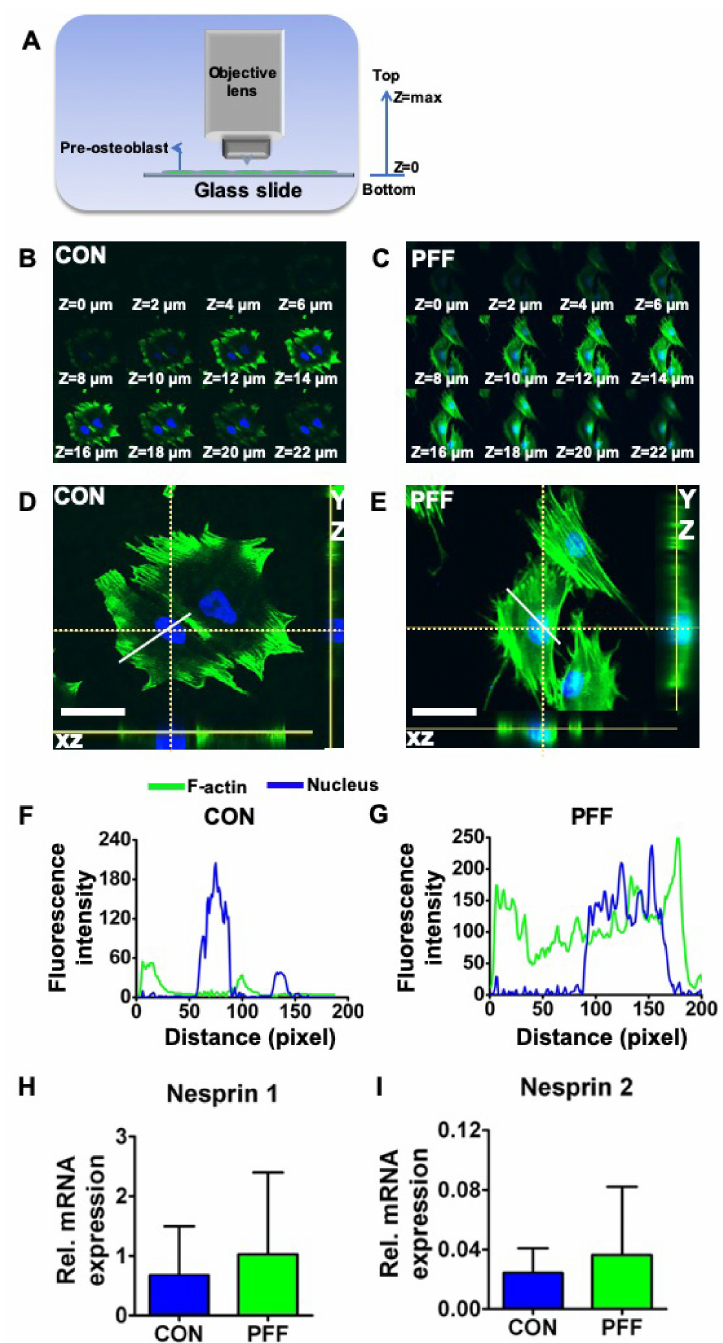
Figure 3. E ff ect of 1 h PFF on 3D F-actin distribution and nucleus position based on morphology and Z-stack analysis by laser scanning confocal microscopy (LSCM), as well as nesprin 1 and 2 gene expression in MC3T3-E1 osteoblasts. ( A ) Illustration of confocal Z-stack scanning direction. ( B ) Z-stack scanning of a typical representative static control cell stained for F-actin and analyzed in the Z-direction at 2 µ m intervals. ( C ) Z-stack scanning of a typical representative 1 h PFF-treated cell. ( D ) Top, XZ, and YZ view of a static control cell. The position of the XZ and XY view are along the dotted white lines. ( E ) Top, XZ, and YZ view of a representative cell, subjected for 1h with PFF. XZ and XY views are along the dotted white lines. ( F ) Fluorescence intensity profiles were analyzed over the solid white line drawn in Figure 3D. ( G ) Fluorescence intensity profiles over representative PFF-treated cells, detected along the solid white line visible in Figure 3E. Bar = 50 µ m. ( H ) Nesprin 1 gene expression in control and PFF-treated cells. ( I ) Nesprin 2 gene expression in control and PFF-treated cells. CON, control; PFF, pulsating fluid